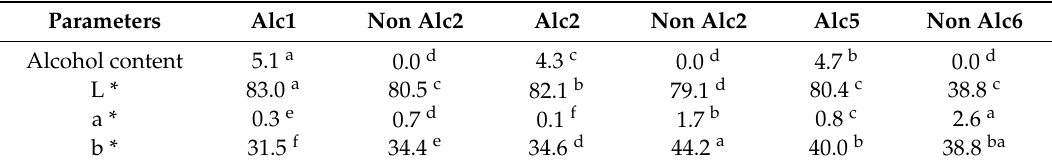
Table 5. Results found for the alcohol contentand color (L *, a * and b *) analyses by means of the Tukey and ANOVA test. Parameters Alc1 Non Alc2